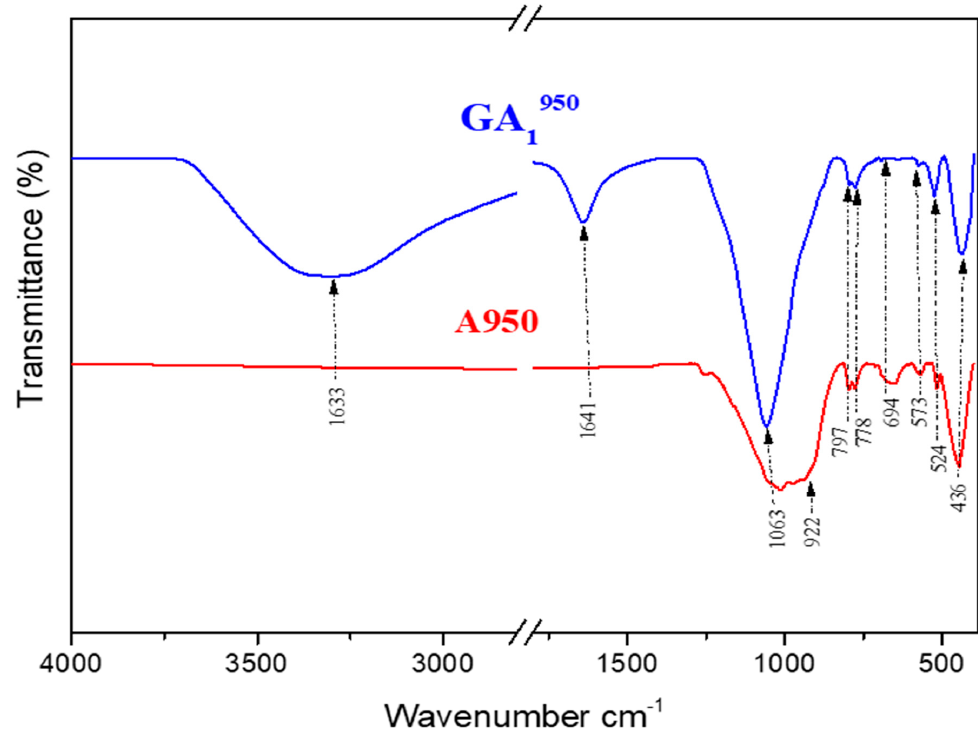
Figure 14. Infrared spectra of GA 1950 geopolymer aged 7 days and A950 clay.